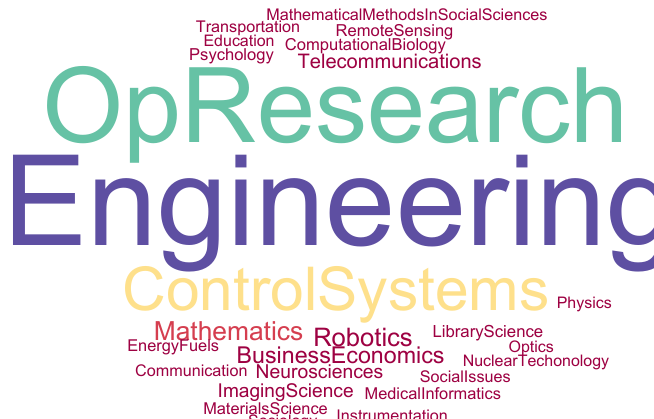
Figure 16. Main application